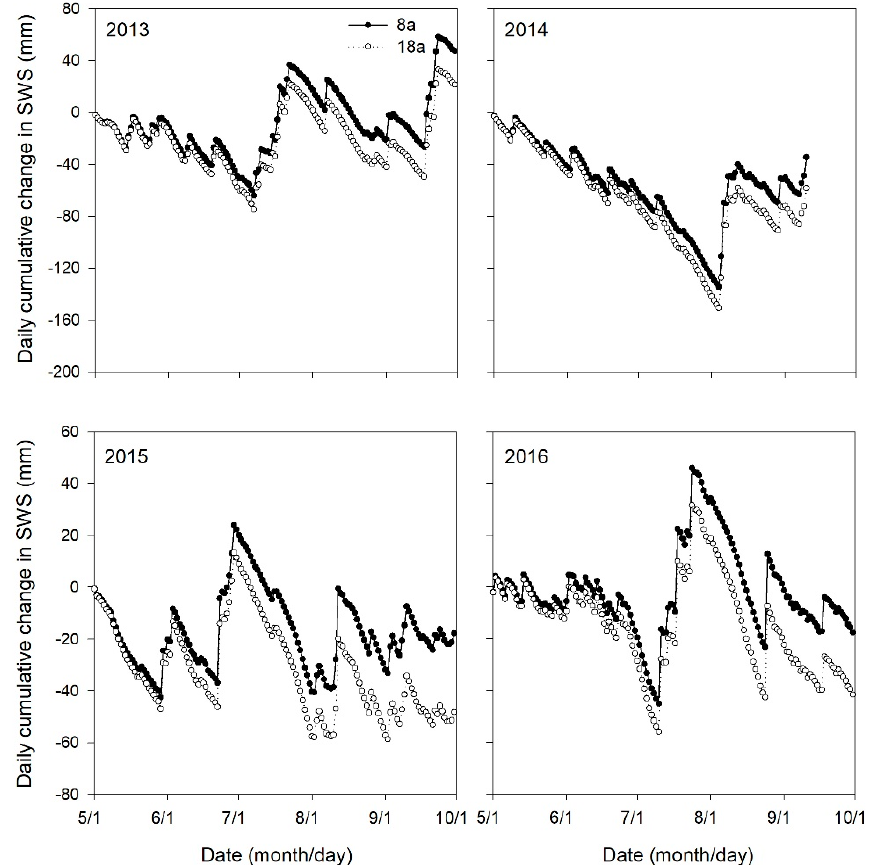
Figure 5. Daily cumulative change in soil-water storage (SWS) for the 8- and 18-year-old apple orchards (8a and 18a, respectively) in 2013, 2014, 2015, and 2016.